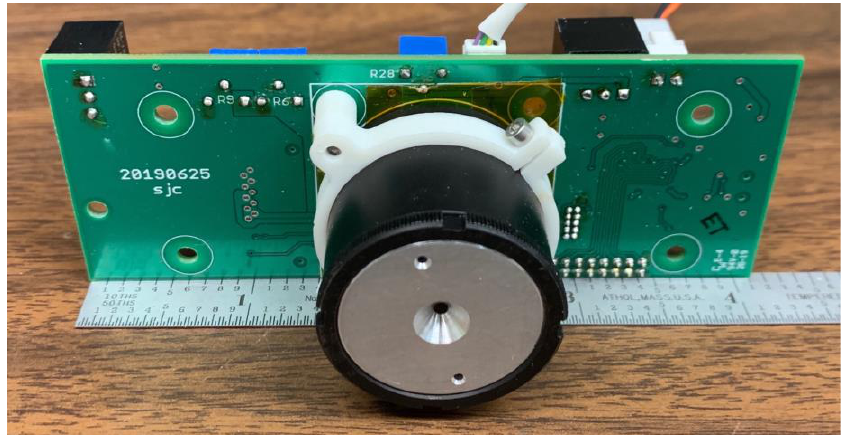
Figure 3. The AWSM custom-built SWIR camera.